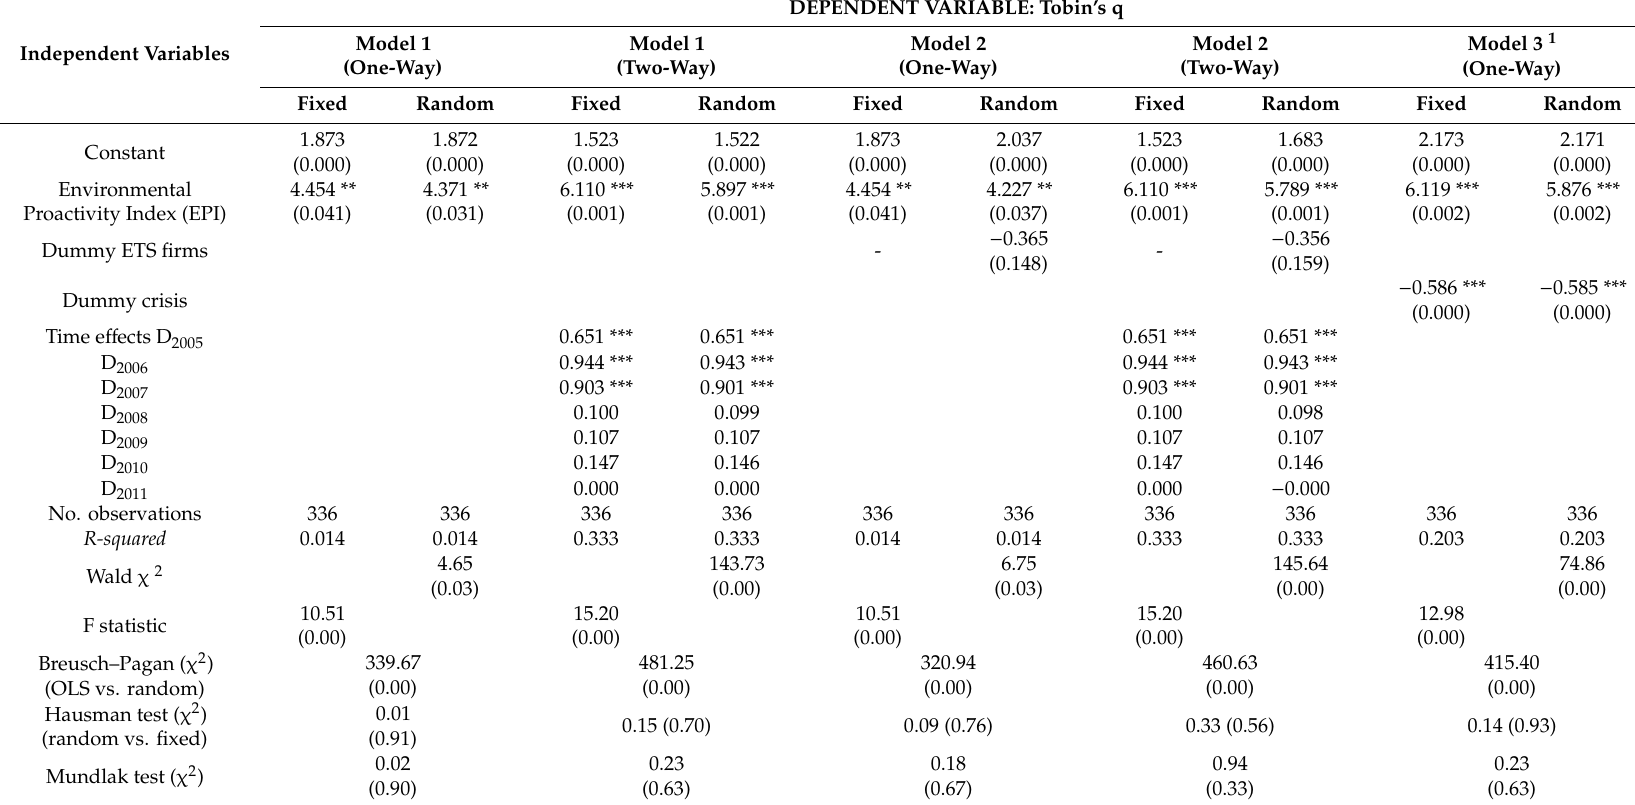
Table 3. Panel estimation. Hypothesis